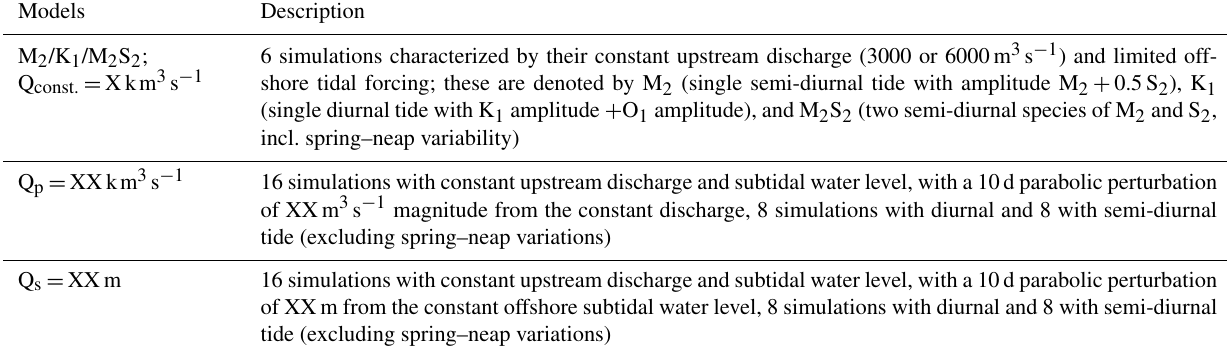
Table 3. Summary of sensitivity analysis simulations and their descriptions.